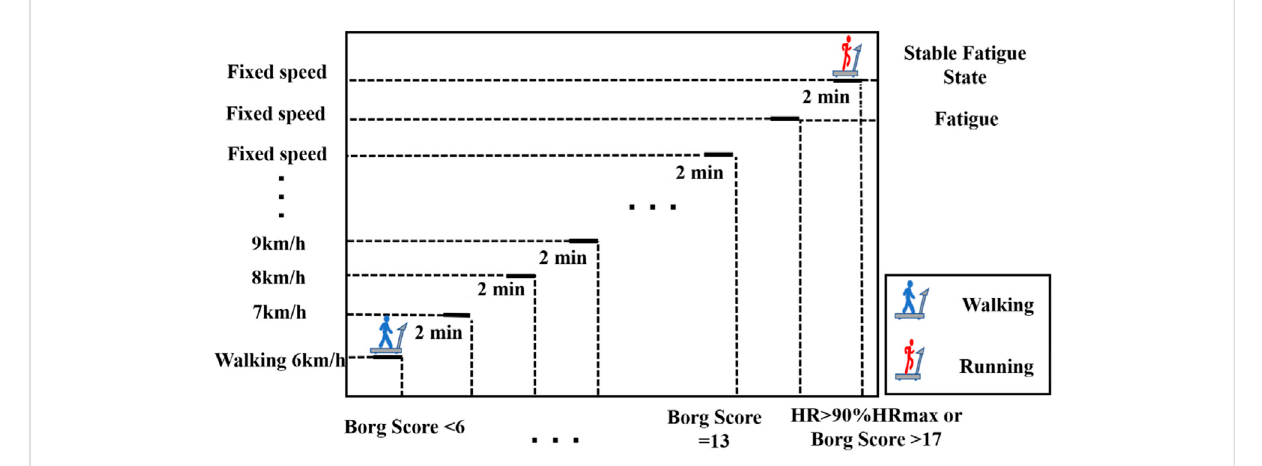
FIGURE 1 Execution method of running-induced fatigue